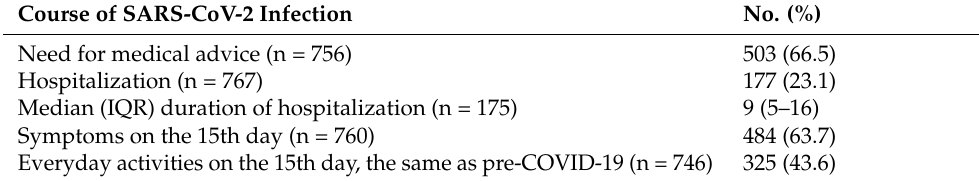
Table 2. The course of SARS-CoV-2 infection in the first wave—need for medical advice, hospi- talization, symptoms on day 15 and ability to perform daily activities two weeks after the start of